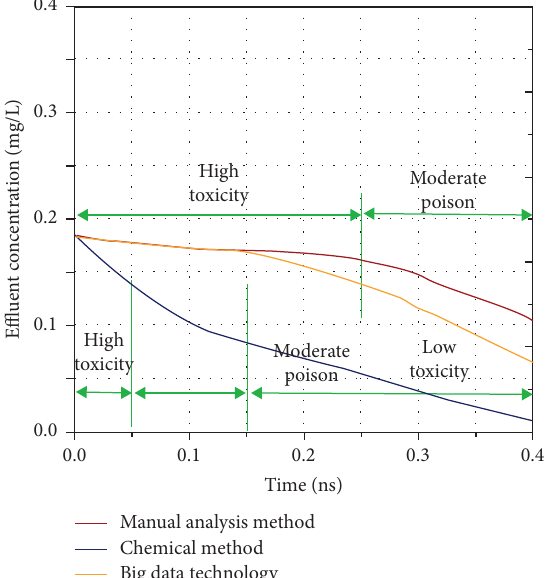
Figure 7: Changing situation of the toxicity of pollutants with medium particle size under different analysis methods.